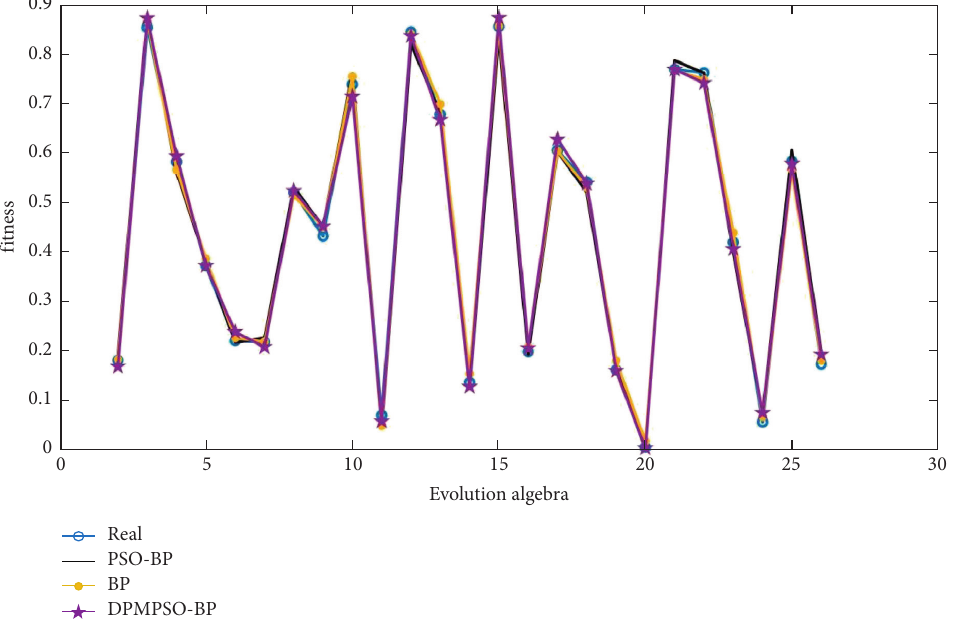
Figure 4: The experimental results of neural